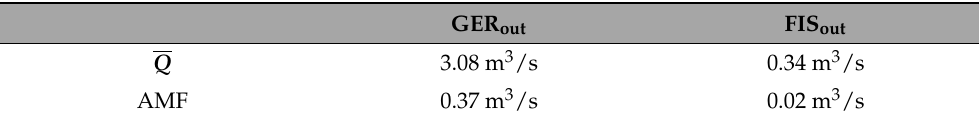
Table 1. Mean discharge ( Q ) and Absolute Minimum Flow (AMF) in the Gersprenz outlet (GER out ) and the Fischbach outlet (FIS out ) for the study period 1980–2018 (data source: The Hessian State Agency for Nature Conservation, Environment, and Geology (HLNUG)